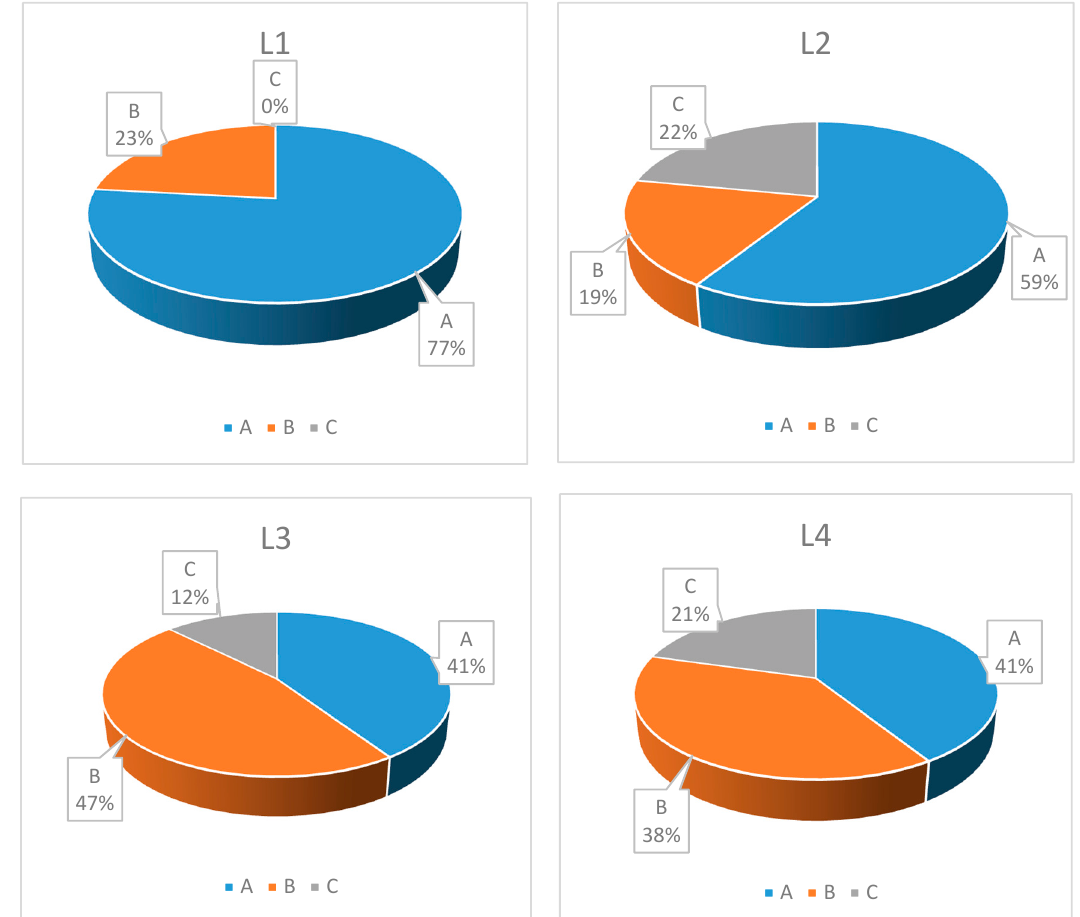
Figure 7. The weight ratio of benefit indices in different stakeholder evaluations.